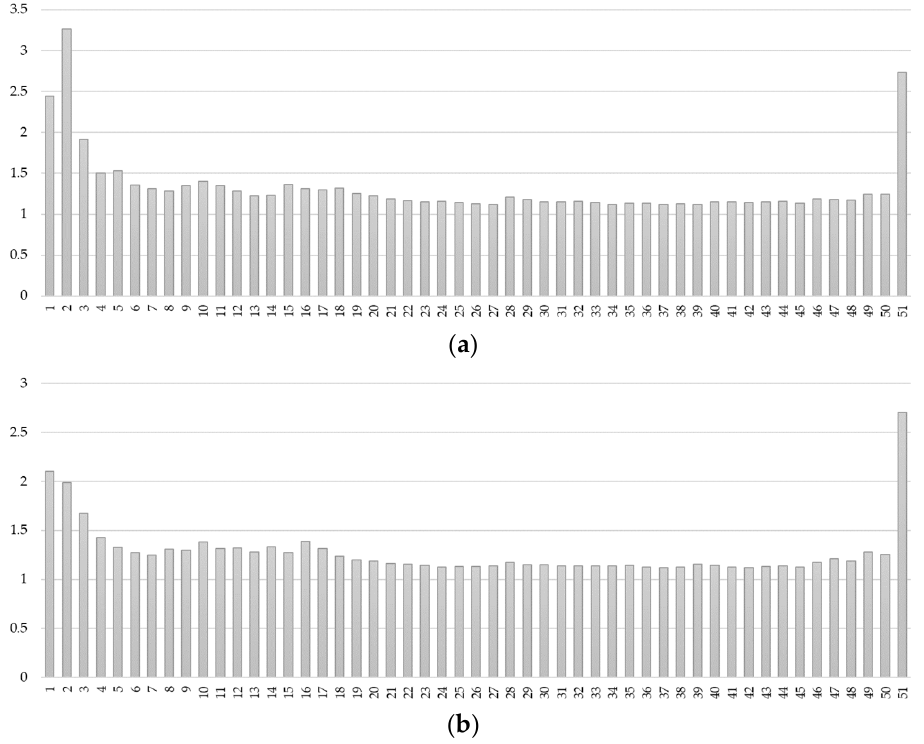
Figure 2. Coefficients quotients in one-by-one merging steps in clustering process: ( a ) excluding the “price” variable; ( b ) including the “price” variable.